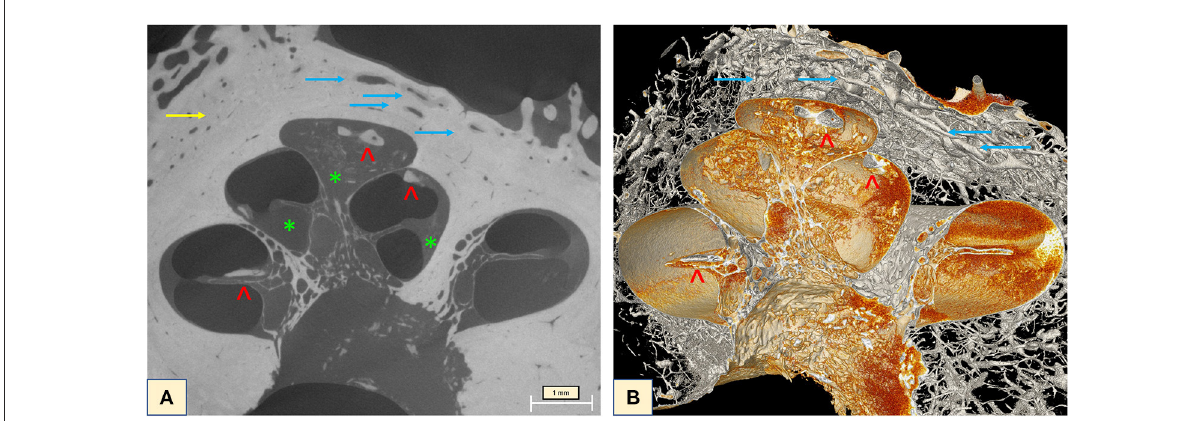
FIGURE3 (A) MicroCT raw image of the full cochlea (6.63 µ m) revealed intense vascularization (blue arrows) and the halo sign (yellow arrow). Extensive fibrotic tissue taking over the apex, the scala tympani of the middle turn, fibrotic tissue (green stars) and lithic formation on top of the OSL and throughout the apex (red arrowheads) were visible with excellent imaging quality. (B) Mesh reconstruction of the cochlea showing the lithic formations throughout the cochlea (red arrowheads) and the intense vascularization of the otospongiotic bone (blue arrows).